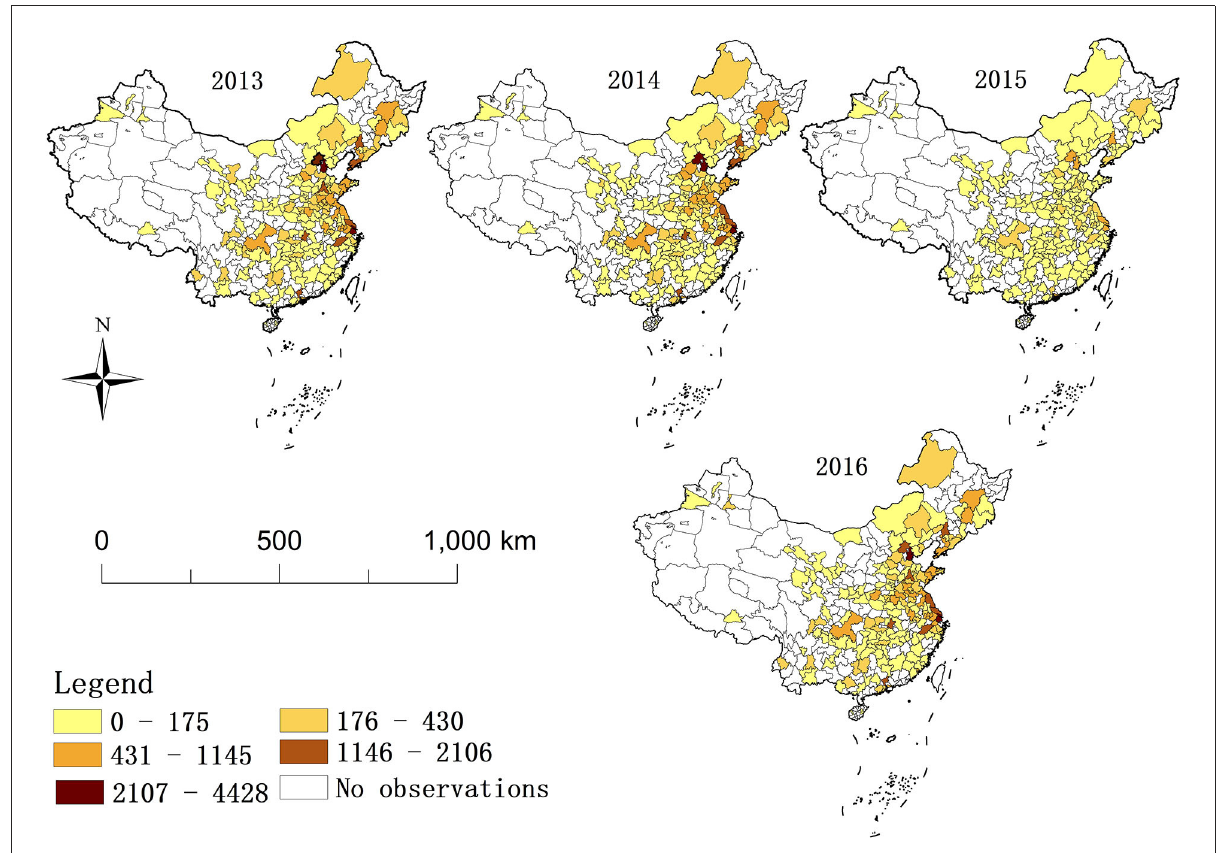
FIGURE1 The scale of breast cancer in 182 Chinese prefectural-level units during 2013–2016.